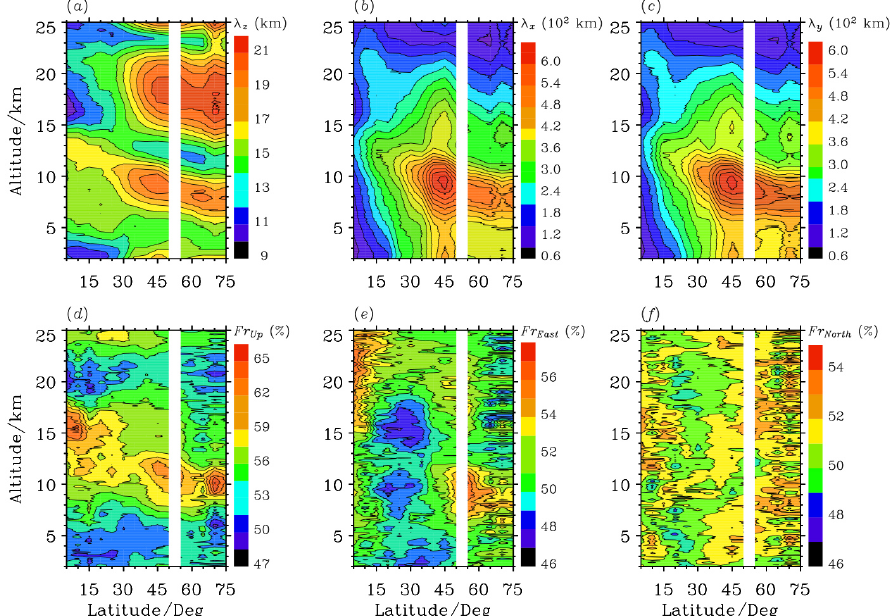
Figure 7. Latitudinal and vertical variations of averaged wavelengths (top) and propagation direction fractions (bottom). In the upper row the left (a) , middle (b) and right (c) panels illustrate the vertical, zonal and meridional wavelengths, respectively. In the lower row, the left (d) , middle (e) and right (f) panels illustrate, respectively, the fractions (in percentage) of upward, eastward and northward propagations. The blanks denote no